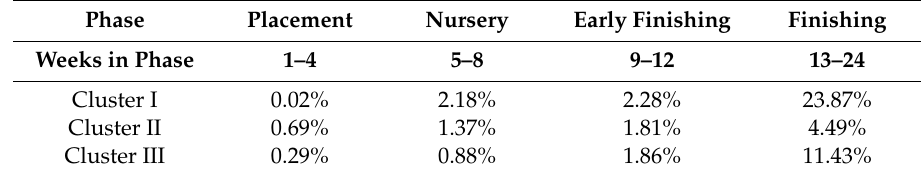
Table 2. Summary of mortality by phase expressed as a percentage of pigs placed at weaning. Phase is name of the period (weeks in phase) for four designations of pig growth used in the financial model.